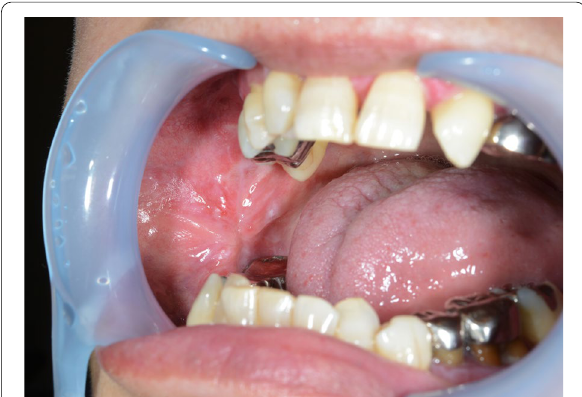
Fig. 1 Clinical presentation, intraoral view. The lesion had been diagnosed as oral lichen planus following biopsy at another hospital, 4 years before the patient’s first visit to my department